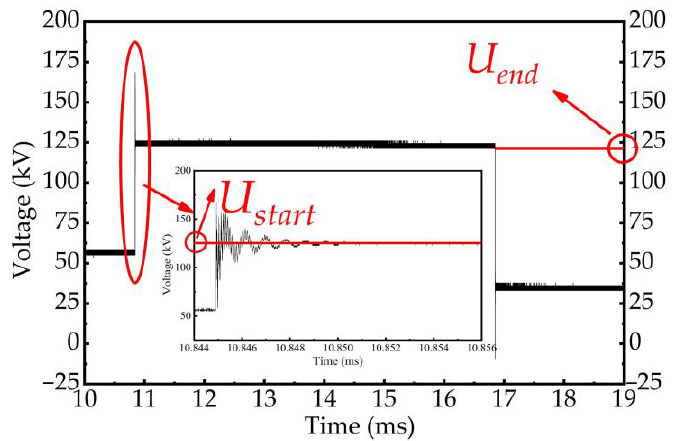
Figure 14. The attenuation changes of trapped charge voltage within the occurrence time of two adjacent high-frequency oscillations.